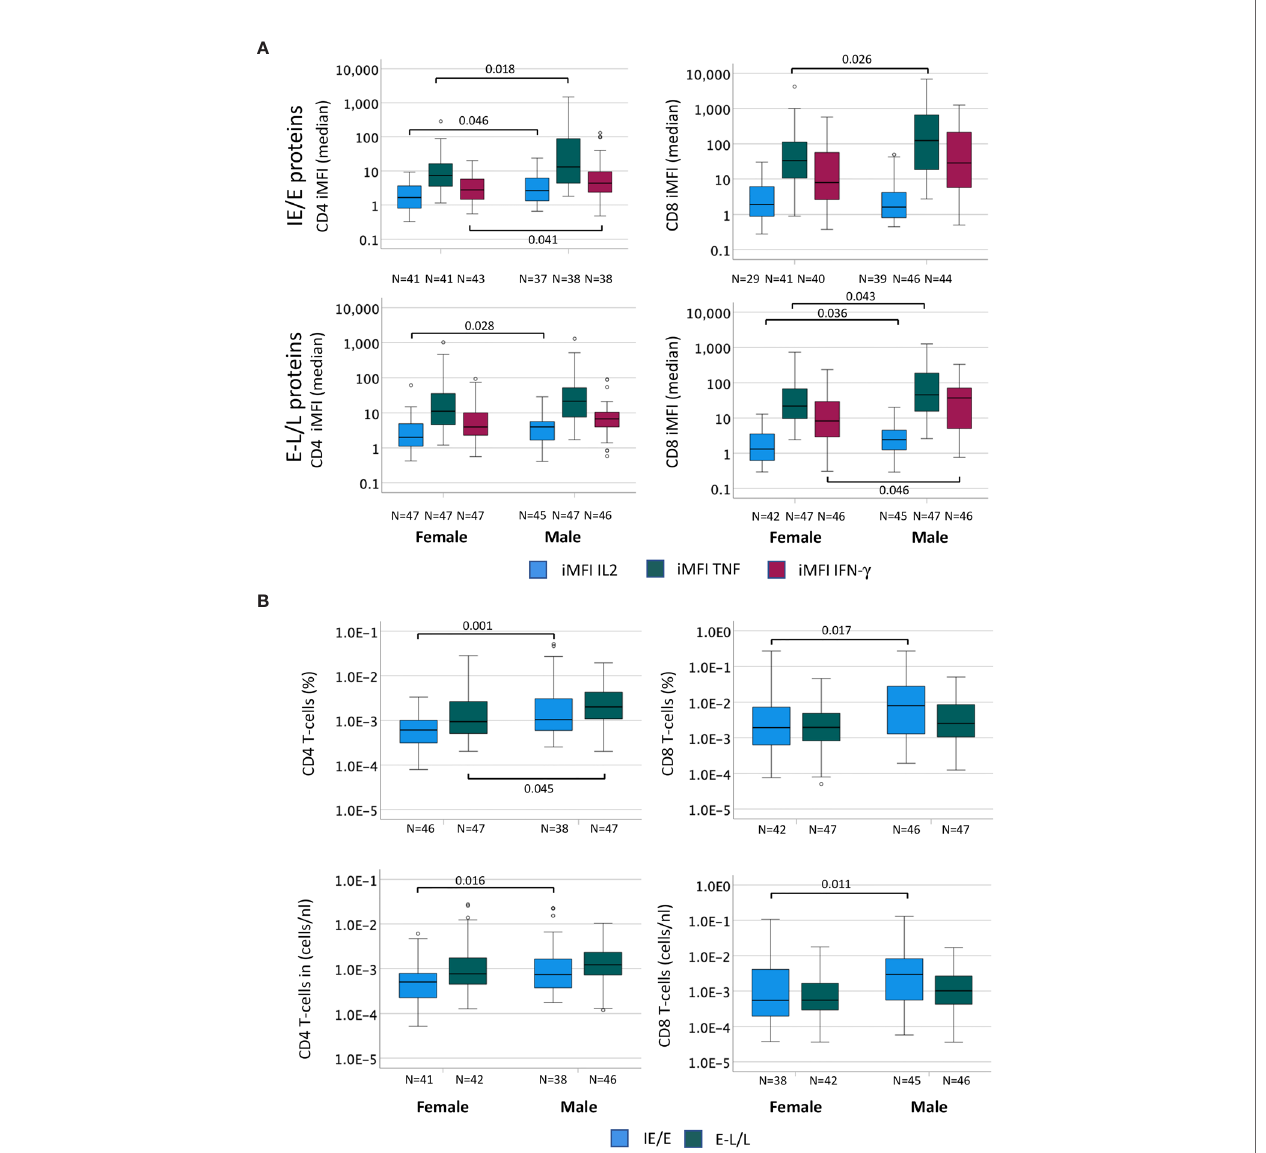
FIGURE 5 | The cytokine content of CMV-speci fi c T-cell responses is higher in men than in women. In order to compare the cytokine amounts produced by CMV- speci fi c T-cells in men and women the percentage (in terms of CD4 or CD8 T-cells) of each cytokine response was multiplied by the MFI to generate the ‘ integrated MFI ’ (iMFI), for CD4 and CD8 T-cells. Responses were grouped by adding up the iMFI of responses to IE/E proteins (UL122, UL123, US3, US24&UL36), more likely to re fl ect CMV reactivation, and those to E-L/L proteins (UL55, UL83, UL32, UL28, UL48, UL151&UL83, UL94&US29). (A) Box plots show the median iMFIs for each cytokine response to IE/E (top) or E-L/L proteins (bottom) by CD4 (left) and CD8 (right) T-cells. (B) Box plots show the median of the summed frequencies or counts (cells/nL) of CD4 (left) and CD8 (right) T-cells responding to IE/E and E-L/L proteins. Box plots show median and interquartile range, outlier limits (whiskers, LQ-1.5*IQR, UQ+1.5*IQR), outliers (o). Within each graph, left and right boxes show responses in females and males,